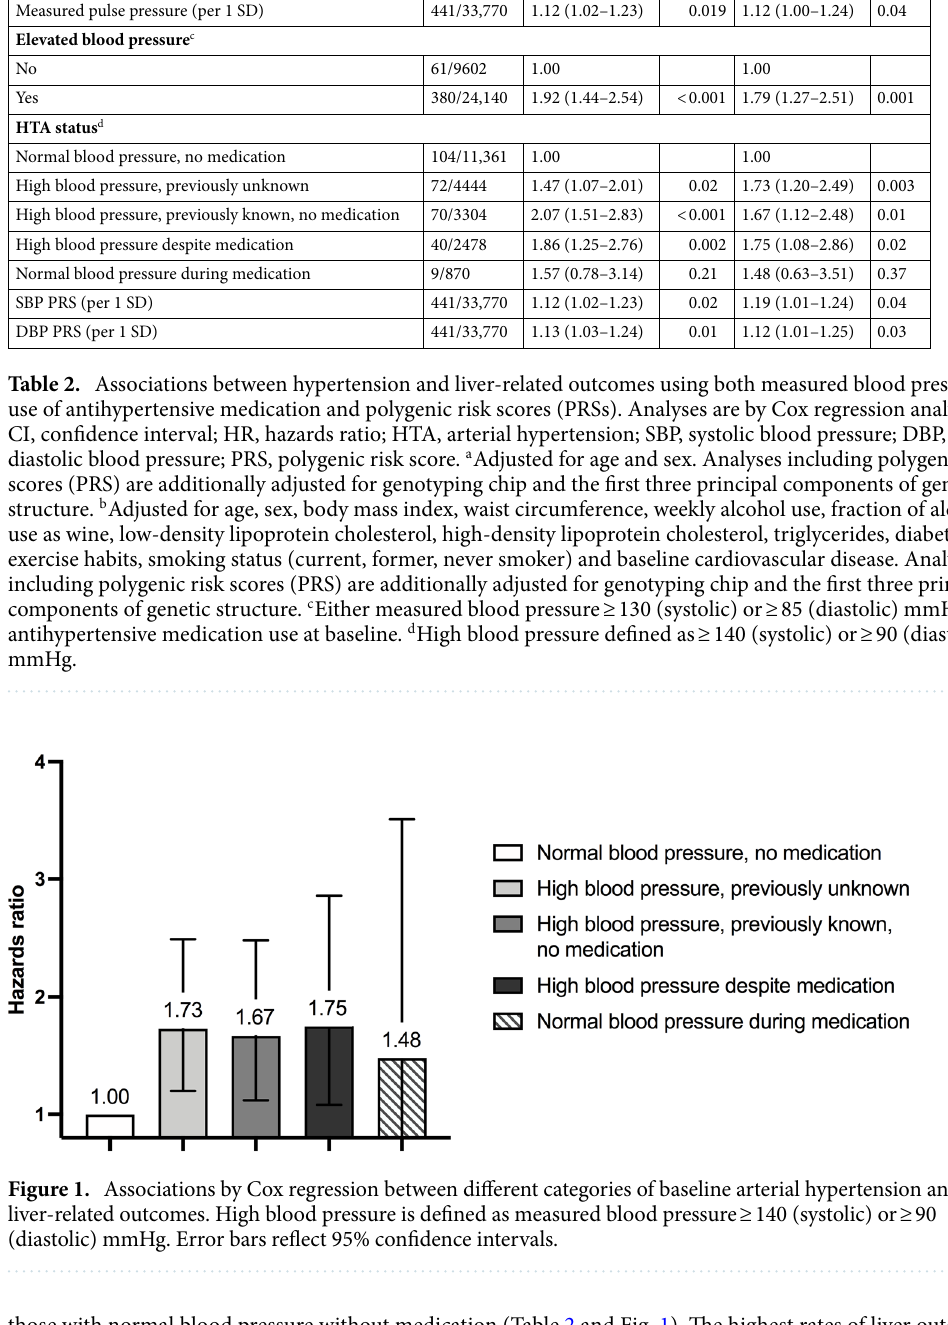
those with normal blood pressure without medication (Table 2 and Fig. 1). The highest rates of liver outcomes were observed among those with high blood pressure despite medication and those with previously unknown HTA, but the confidence intervals were overlapping between categories. In separate Cox regression models considering the PRSs as independent variables, both the SBP and DBP PRSs were significantly associated with liver-related outcomes in both age- and sex-adjusted models and in the fully adjusted models (Table 2). Interaction terms between SBP PRS or DBP PRS and alcohol use, BMI, waist circumference, diabetes, and prevalent cardiovascular disease were all non-significant (Supplementary Table 2). We next studied possible effect modification from the metabolic syndrome. In Cox regression analysis with age, sex, alcohol use, SBP or DBP PRS, metabolic syndrome, and the interaction terms between the PRSs and metabolic syndrome as covariates, the risk for liver-related outcomes increased along with the SBP PRS and DBP PRS both among those with and without the metabolic syndrome (Supplementary Fig. 2). Both SBP PRS and DBP PRS were significantly associated with liver-related outcomes among subjects without baseline metabolic